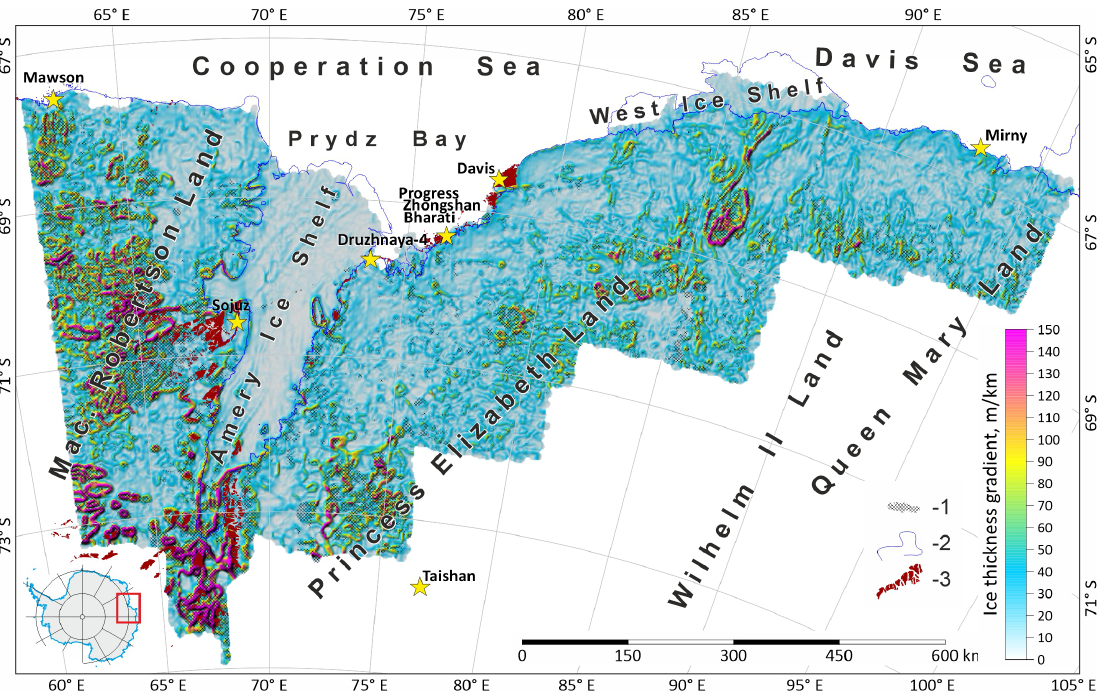
Figure 7. Ice thickness gradients of the research area. 1—areas with grid errors greater than 75 m; 2—ice front and grounding line from [20]; 3—outcrops from